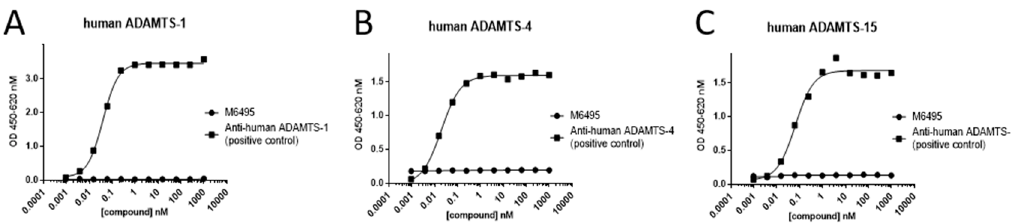
Figure 1. Specificity of the M6495 Nanobody. ( A – C ), M6495 do not bind to ADAMTS, 1, 4 and 15.